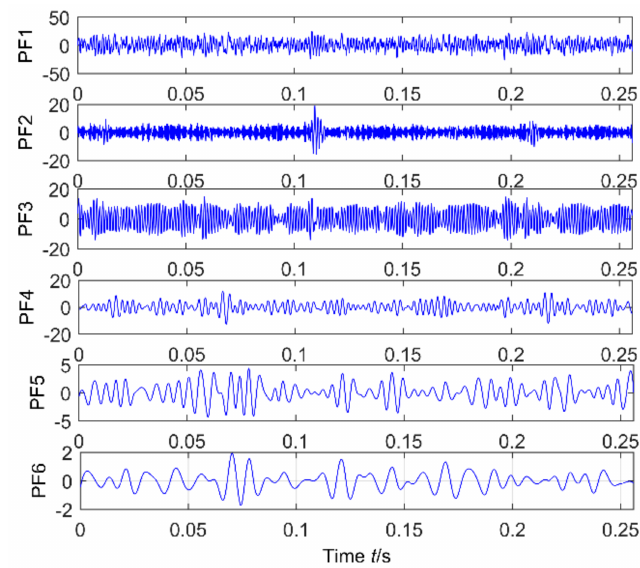
Figure 20. ELMD of a faulty gearbox.